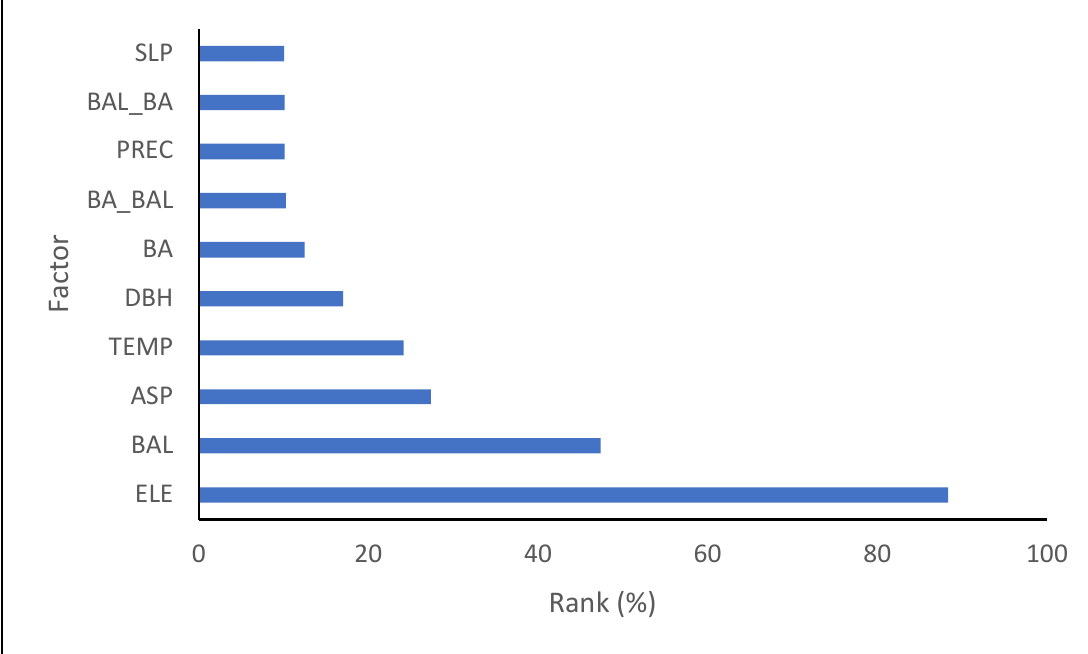
Figure 9. Relative importance of the predictor factors measured by the MLP model. SLP is slope, BA is basal area, BAL is basal area in largest trees, PREC is participation, DBH is diameter at breast height, TEMP is temperature, ASP is aspect, and ELE is elevation.